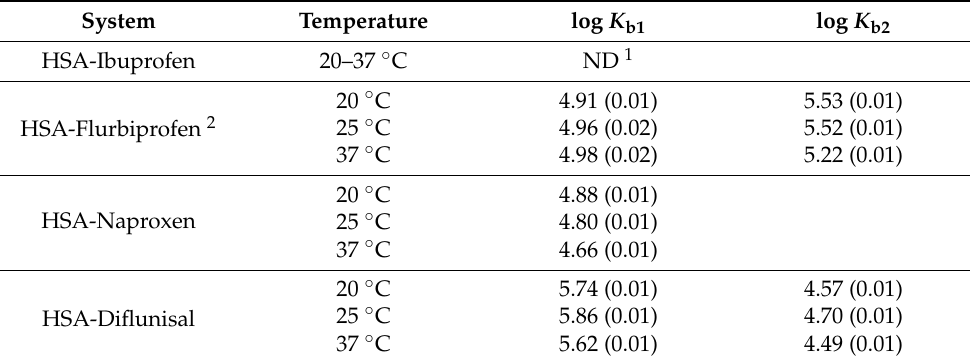
Table 3. Stoichiometry and binding constants obtained using the STAR program approach consider- ing the three selected fluorescence modes simultaneously. K b1 and K b2 correspond to the binding constants of 1:1 and 1:2 stoichiometry processes, respectively. Standard deviations are noted in